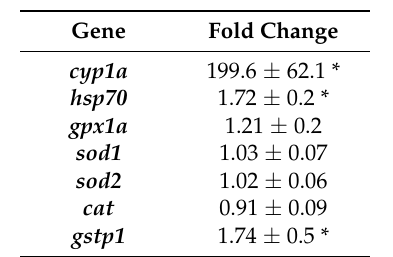
Table 4. Expression of genes involved in the redox status of the embryo after exposure to PCB126 (25 nM) and after deformity development at 3 dpf. Relative expression was calculated respect the housekeeping gene ( gapdh ) and control (0.01% acetone). Data are represented as mean ± SEM of n = 3 pools of 15 embryos from different biological replicates. Asterisk indicates significant induction compared to the vehicle control ( p <